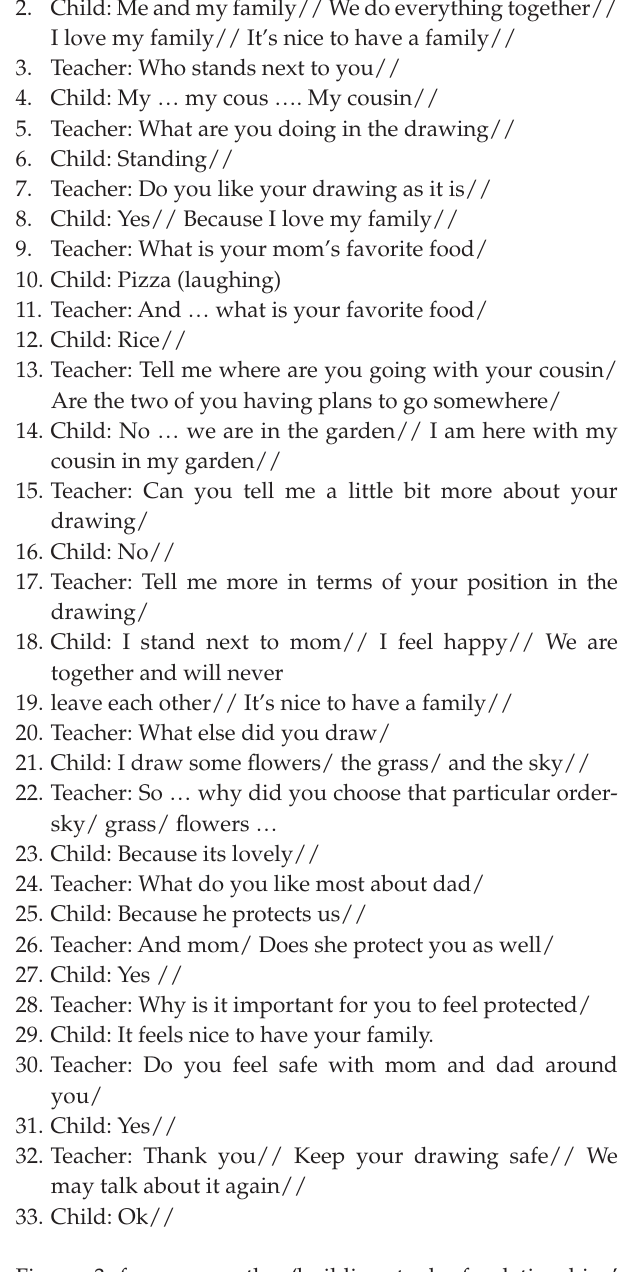
Figure 3 focuses on the ‘building tool of relationships’ (Rogers 2011:31), and has an information focus: six family members holding hands while standing on a lawn with flowers that are